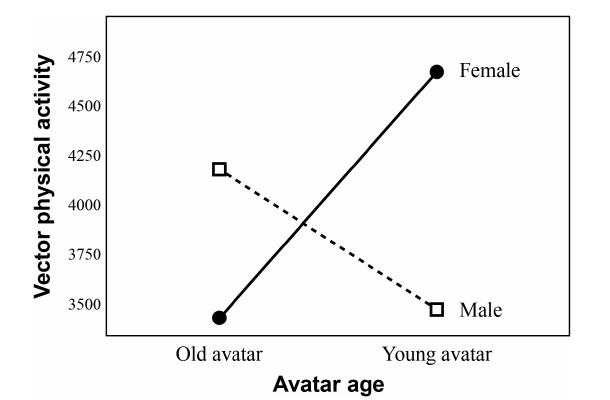
FIGURE 7 | Interaction between avatar age and sex of participants in predicting vector physical